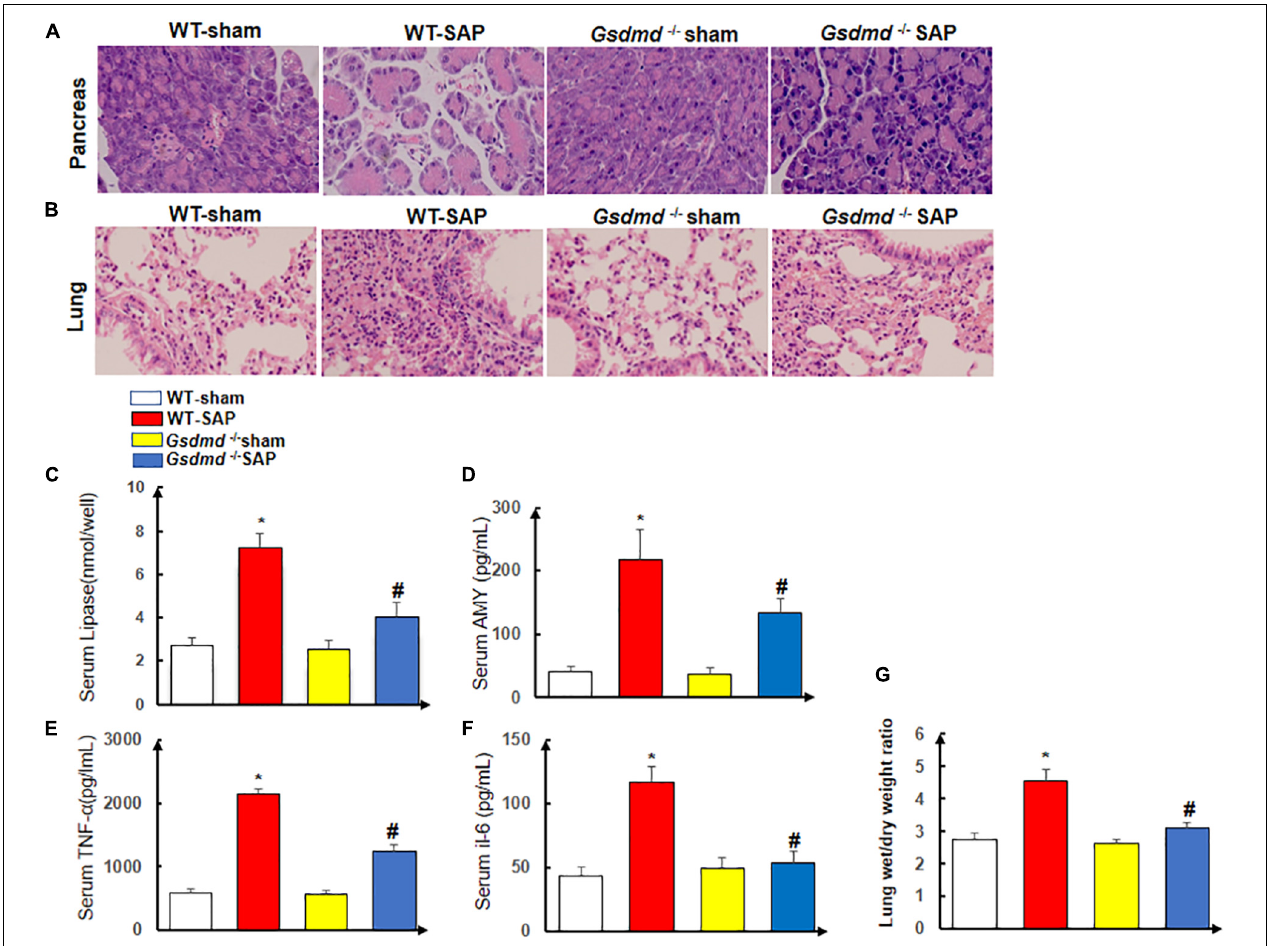
FIGURE 3 | Gsdmd deficiency attenuates the injury of the pancreas and lung. Mice were sacrificed 24 h after LPS injection, and samples were collected. (A,B) H&E staining of the pancreas and lung in four groups was performed, and the morphologies were photographed at × 200 enlargement. (C–F) The levels of serum lipase, amylase, TNF- α , and IL-6. Experiments were repeated three times. *p < 0.05 vs. other groups; # p < 0.05 vs. Gsdmd − / − sham group in the expression of lipase, amylase, TNF- α , and IL-6. (G) Lung tissue wet/dry ratio was measured. All the data are expressed as mean ± SD, n = 10 per WT group, n = 8 per Gsdmd − / − group. LPS, lipopolysaccharide; WT, wild